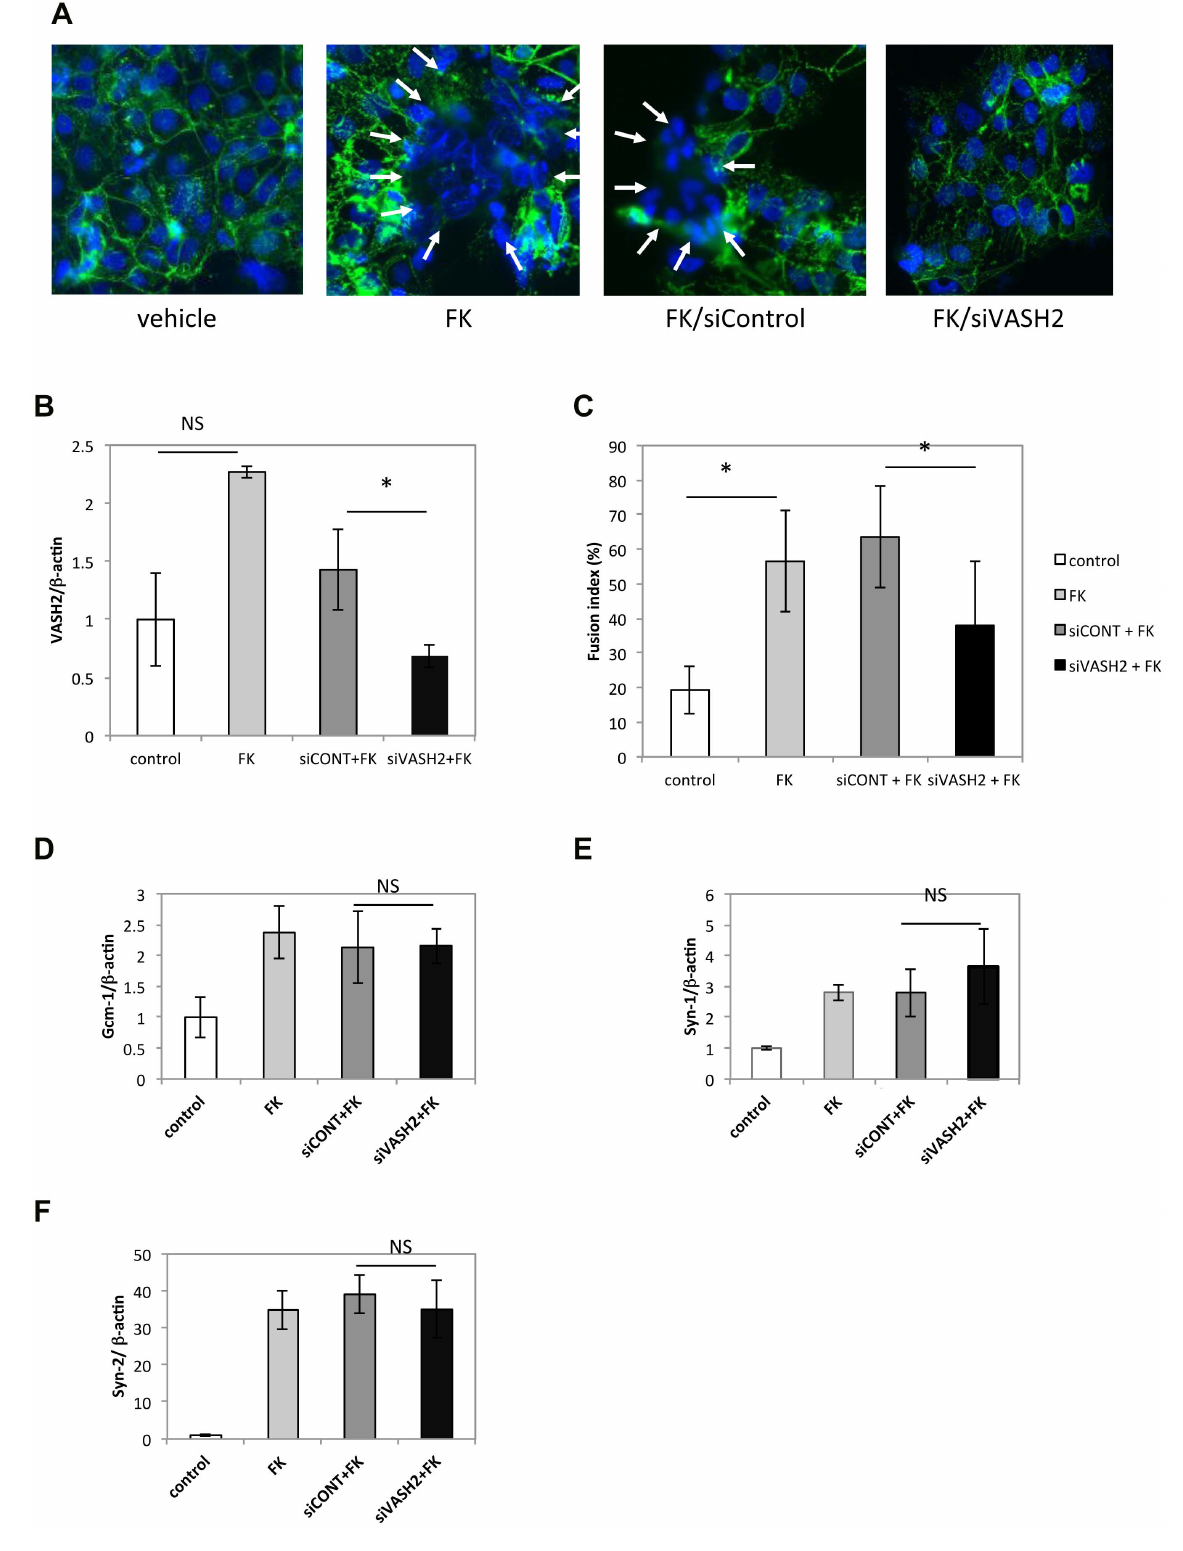
Figure 6. Knockdown of VASH2 inhibited the forskolin-induced fusion of BeWo cells. A: BeWo cells with or without siRNA treatment were stimulated with FK, and cell fusion was observed as described in Materials and Methods. Bar=100 m m. Arrows indicate fused cells with multiple nuclei. B: Expression of human VASH2 was quantified (N=3). *P , 0.01, NS; not significant. C: Cell fusion was quantified as described in Materials and Methods (N=2, 10 fields each). *P , 0.01. D–F: Expression of Gcm-1, Syn-2, and Syn-1 in BeWo cells with each treatment (N=3) was determined by qRT-PCR. NS; not significant. doi:10.1371/journal.pone.0104728.g006 PLOS ONE |